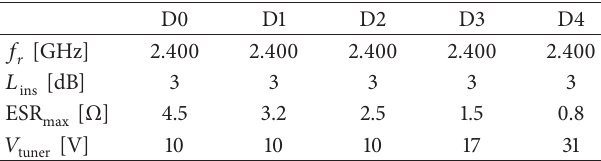
Table 4: Tuner requirements.